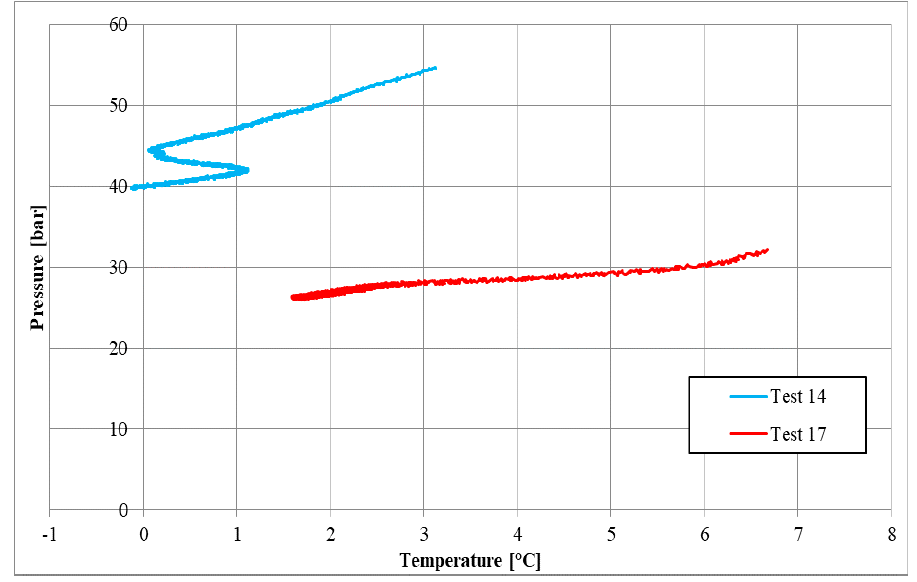
4 , and Test 16, performed with CO 2 .